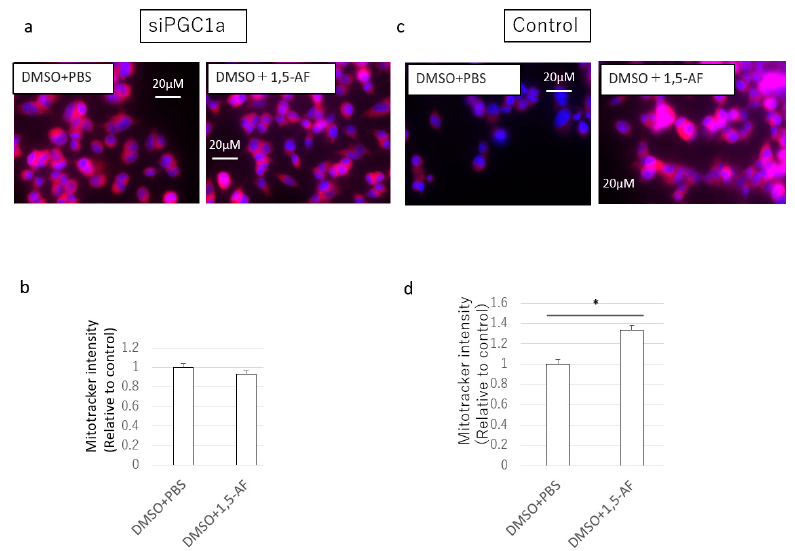
Figure 8. Effects of PGC-1 α silencing on the mitochondrial protective activity of 1,5-AF in cultured PC12 cells. ( a ) Rep- resentative confocal images of MitoTracker staining in cells transfected with PPARGC1A small interfering RNA (siRNA; magnification: 100×, scale bar: 20 µm). ( b ) Transfection with PPARGC1A siRNA inhibited the increase in MitoTracker intensity of 1,5-AF-treated cells. ( c ) Representative confocal images of MitoTracker staining in cells transfected with con- trol siRNA (magnification: 100×; scale bar: 20 µm). ( d ) In cells transfected with control siRNA, treatment with 1,5-AF in- creased the MitoTracker intensity in DMSO-treated cells. All data are expressed as the mean ± standard error of the mean. * p < 0.05. 1,5-AF, 1,5-anhydro-D-fructose; DMSO, dimethyl sulfoxide; PBS, phosphate-buffered saline; siPGC1a, cells transfected with PPARGC1A siRNA.